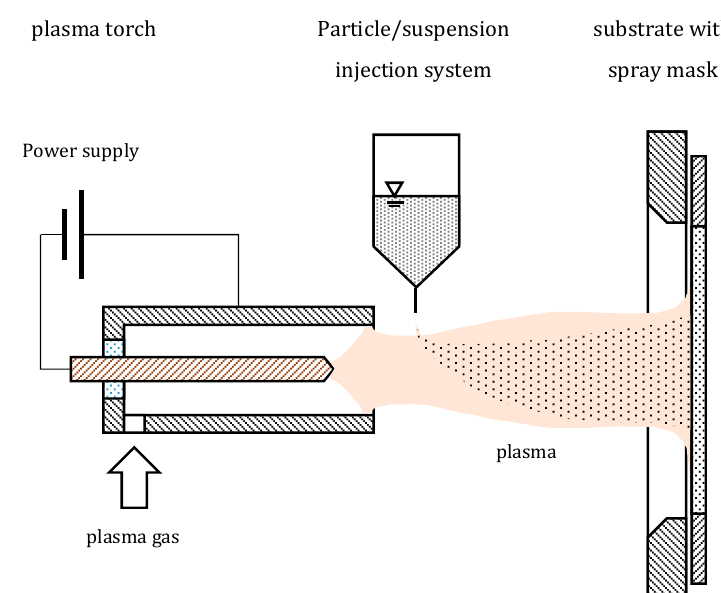
Figure 4. Schematic sketch of a plasma spray facility to produce metallic membrane layers on porous substrates. Plasma is lighted in a plasma torch, and carried out by the plasma carrier gas. Metal particles, or a suspension of metal particles, are injected into the plasma. The molten metal particles hit the substrate surface with high velocity, and form a dense metal layer. Sketch after [6].